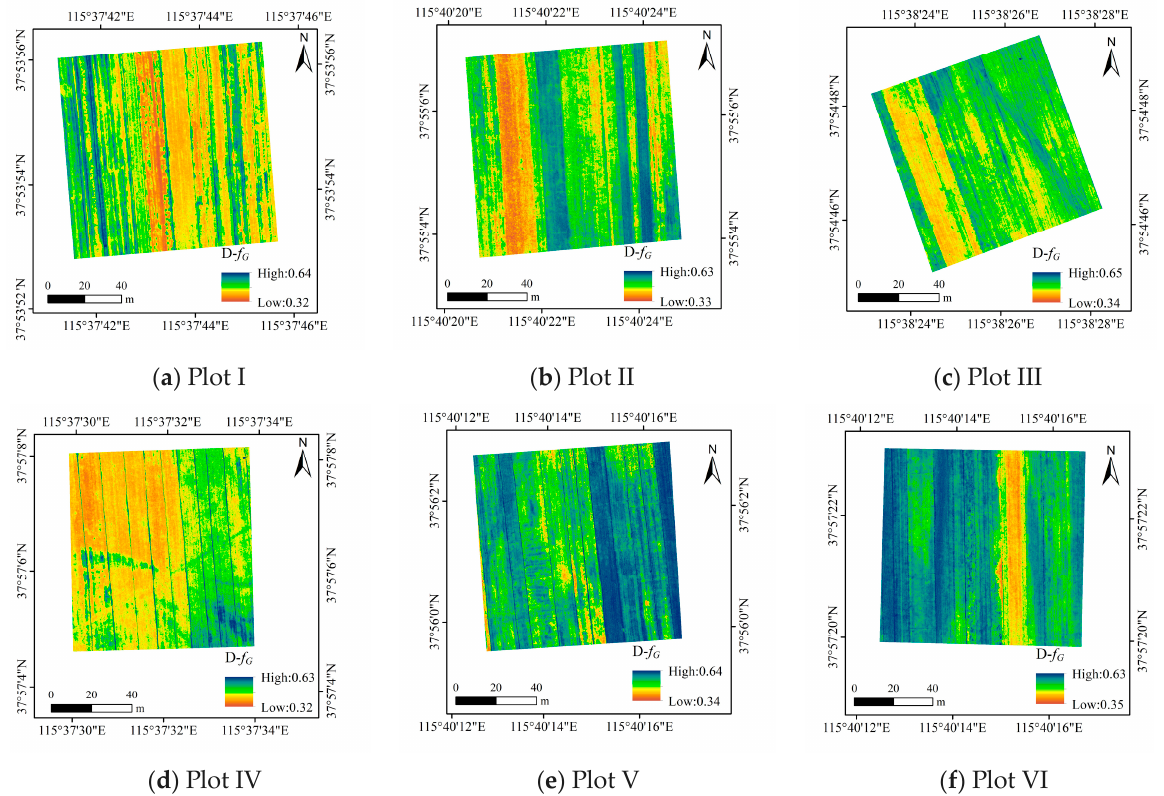
Figure 10. D- f G results of each flight plot based on the sensitive band centers λ (724 nm, 784 nm) (4 June 2021). Table 3. Statistics of the NDSI and D- f G in each flight plot in different crop growth periods.